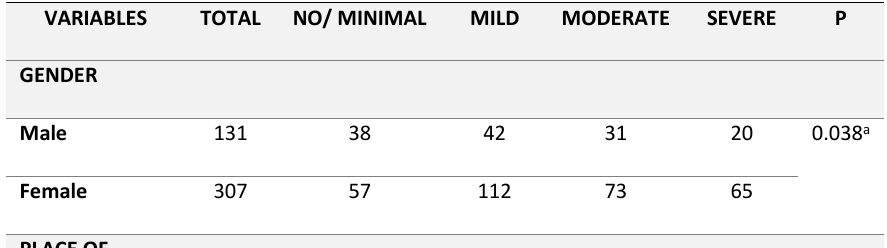
Table 1. Comparison of different independent variables with severity of anxiety levels of study